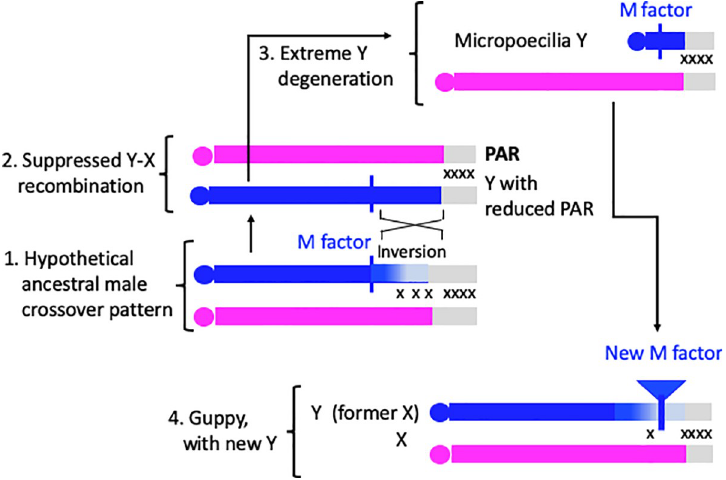
Fig 4. Diagram of hypothesis 2 for the evolution of the guppy Y chromosome. This hypothesis involves the appearance of a new maleness (M) factor on an X chromosome like that in M . picta . The diagram shows 4 proposed stages, indicated by numbers, from a hypothetical ancestral state (numbered 1) to the guppy state (4). Regions where crossovers occur are indicated by ‘x’ symbols, with high and low densities of symbols indicating high or low crossover rates, respectively. The ancestral state might rarely have undergone crossovers, indicated by ‘x’ symbols in a small distal part of the centromere-proximal end of the chromosome pair. A completely non-recombining Y-linked region, like that in extant M . picta males, could have evolved by an inversion (stage 2, see text), followed by complete genetic degeneration (stage 3). Possible sources of a new maleness factor in the guppy are discussed in the text. If phenotypic males rarely have crossovers in the part of the chromosome to the left of the maleness factor, this region would become closely linked with maleness. In the case of a duplication, a completely Y-linked region might also be created (expanding the guppy Y, compared with the X), but the centromere-proximal part of the chromosome could still occasionally recombine with the X, preventing genetic degeneration.